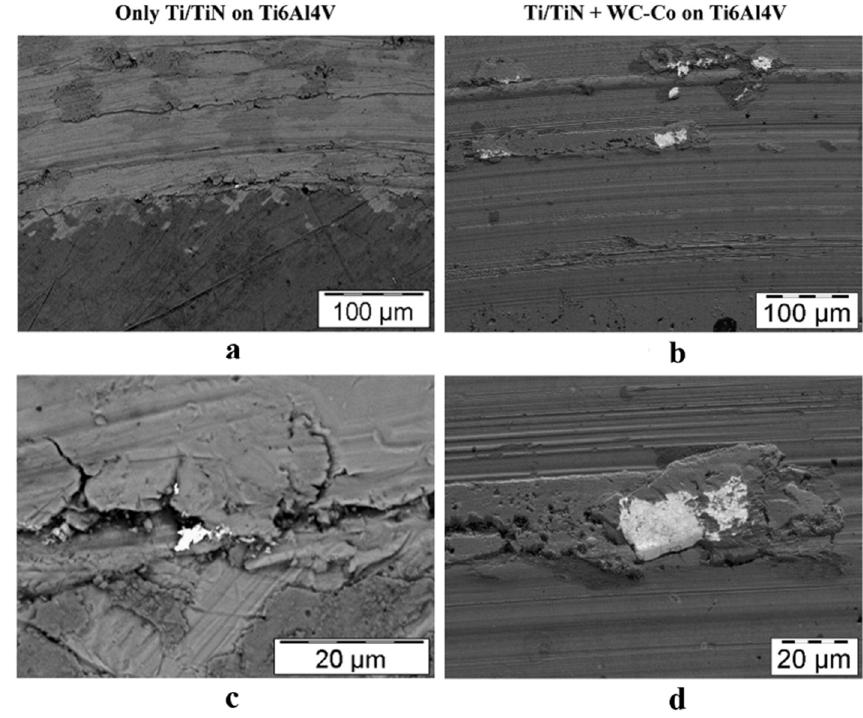
Figure 10. The surface wear track morphology of ( a , c ) PVD coating and ( b , d ) HVOF-PVD duplex coating on Ti6Al4V substrate. Reprinted with permission from Ref. [61]. Copyright Elsevier, 2008.